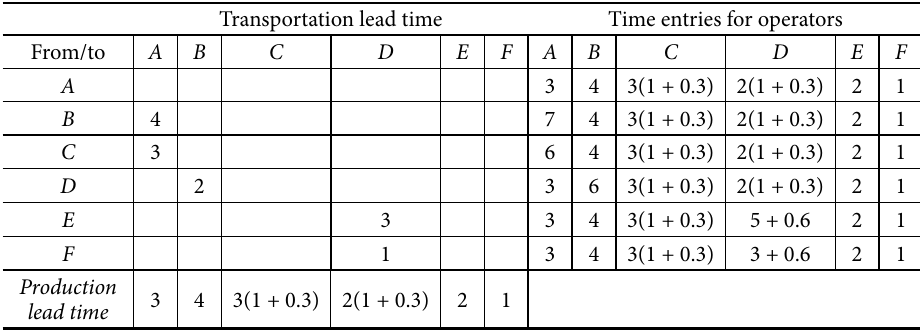
Table 1. The transportation time distance between the nodes and the production lead times of the example, where perturbations in delay at C and D appear as 30% of the initial value Transportation lead time Time entries for